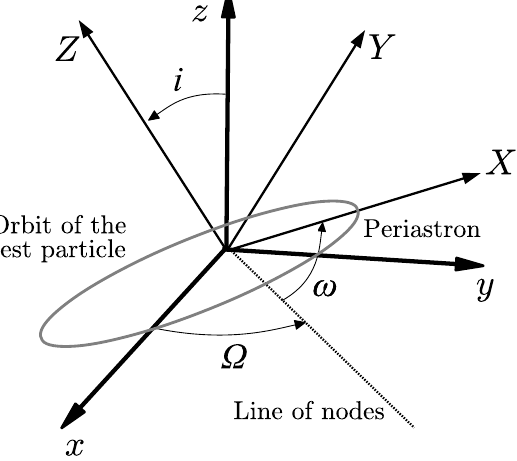
Figure 1. Unperturbed orbit of the test